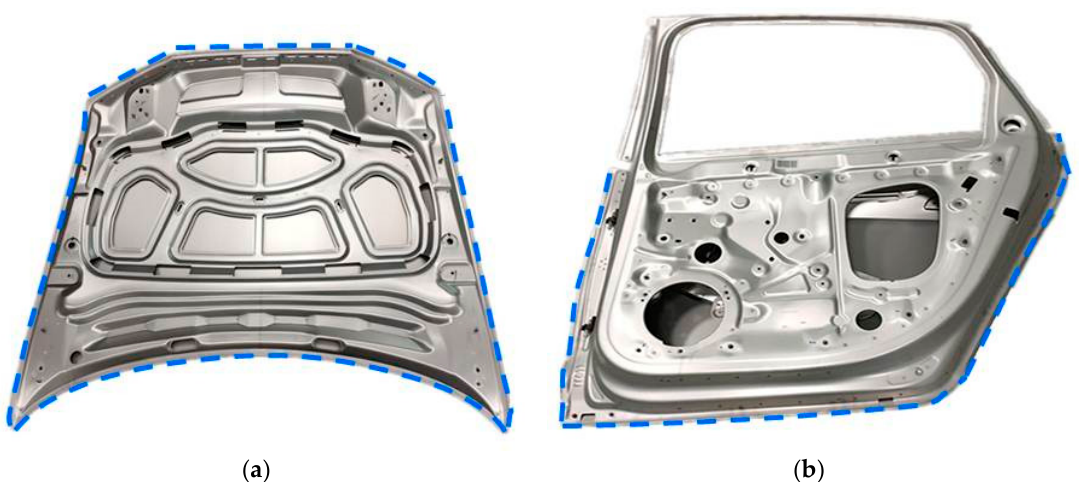
Figure 2. The typical aluminum hemmed components in autobody, the dotted blue lines represent the hemmed edges. ( a ) Hood hemming assembly and ( b ) door hemming assembly.